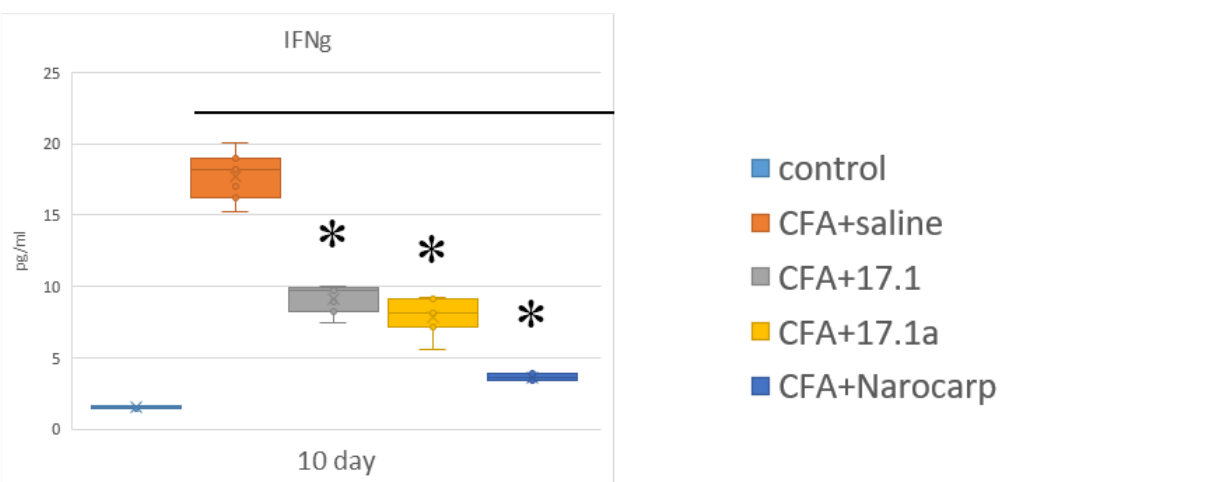
Figure 4. Changes in the level of hematopoietic cytokines (( A ) IL-7) and growth factors (( B ) G-CSF; (( C ) M-CSF) in the plasma of mice after CFA-induced arthritis. (Control — control animals without CFA injection, CFA — animals with induced via CFA arthritis, +saline — animals were treated by phosphate buffered saline (PBS), +17.1a, +17.1, +Norocarp — animals were treated by a specified agent, n = 7 for each group). ( p -value: * < 0.05).